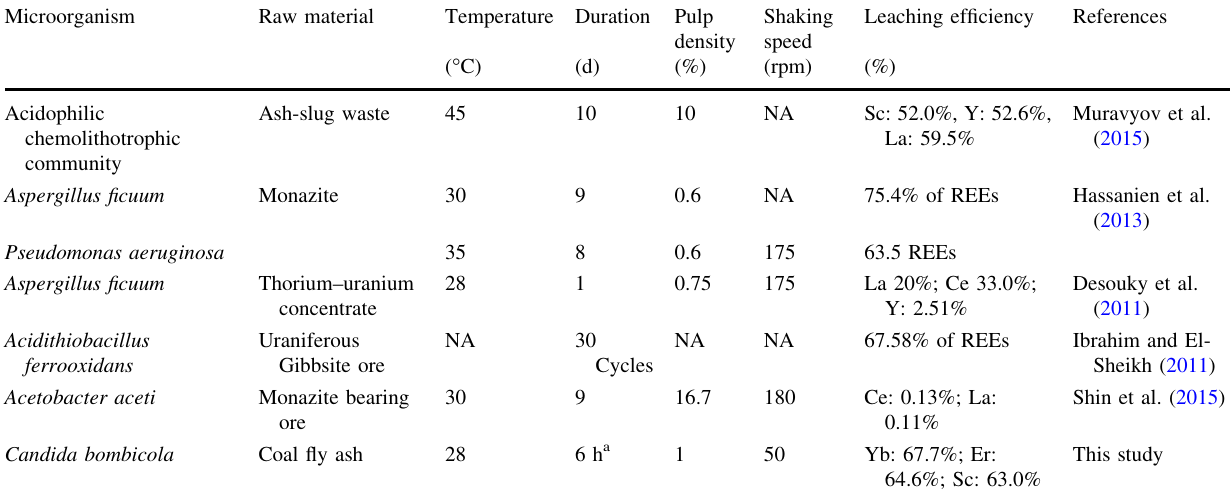
Table 2 Comparison of leaching efficiency among different studies Microorganism Raw material